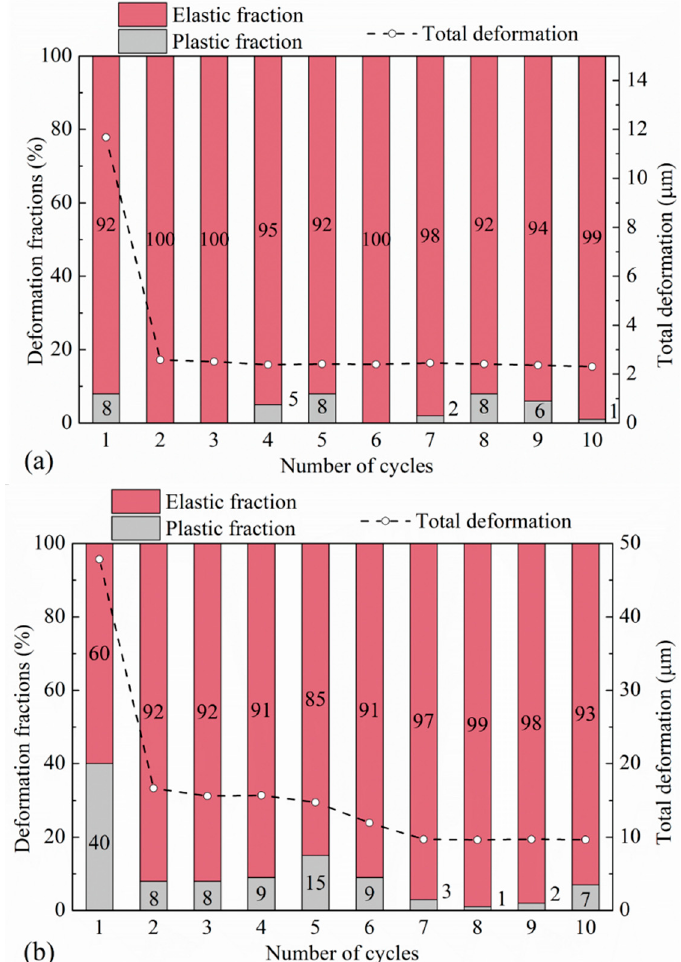
Figure 12. Displacement magnitude and different fractions in preloading for ( a ) LBS–LBS and ( b ) CDG–CDG contacts.